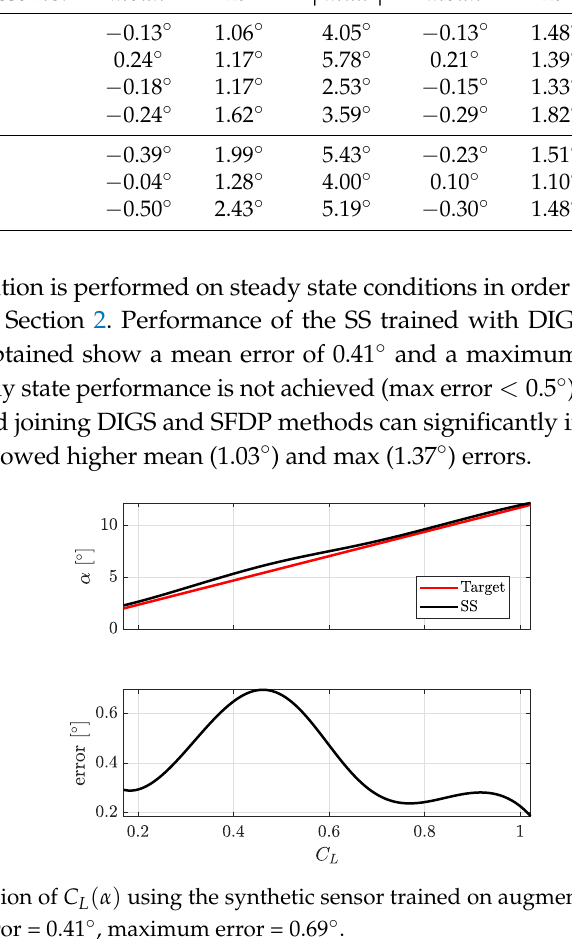
Table 3. PDF characteristics of the corresponding flight test. The 2 σ value is calculated as the error of the 95.45% of the data points. SS Original [24]